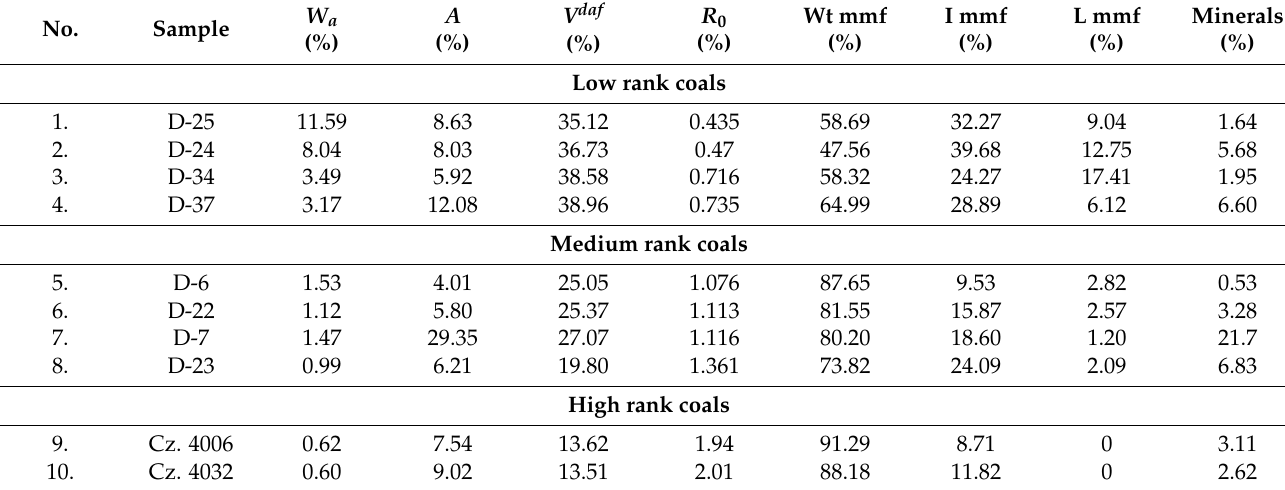
Table 2. Results of petrographic analyses.